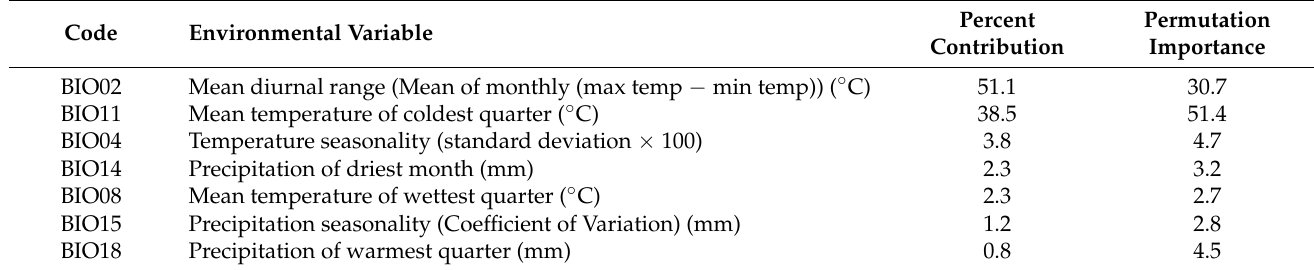
Table 1. Environmental variables and their contributions and suitable value ranges.